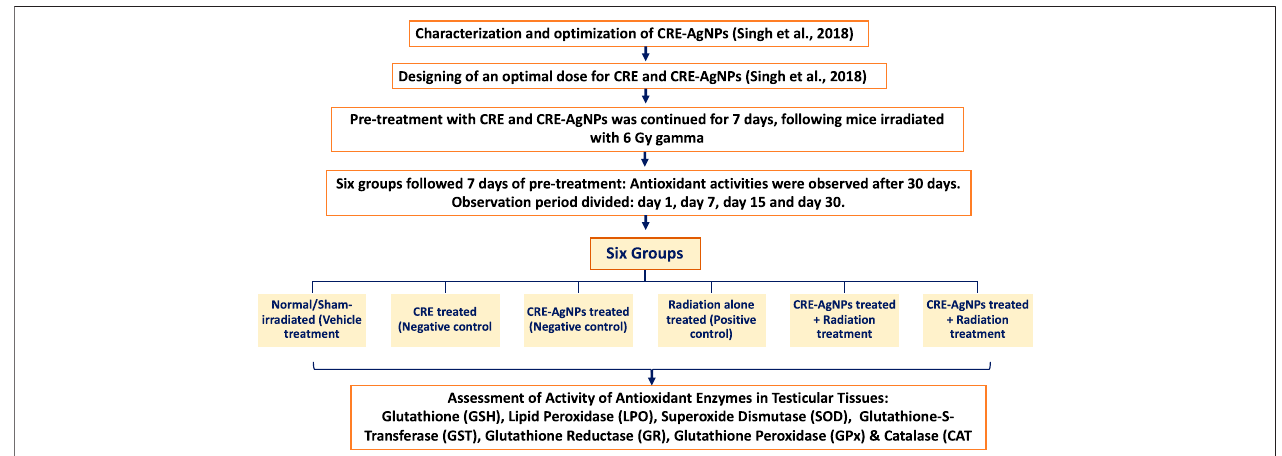
FIGURE 1 | Illustration of experimental design and groups along with measurement